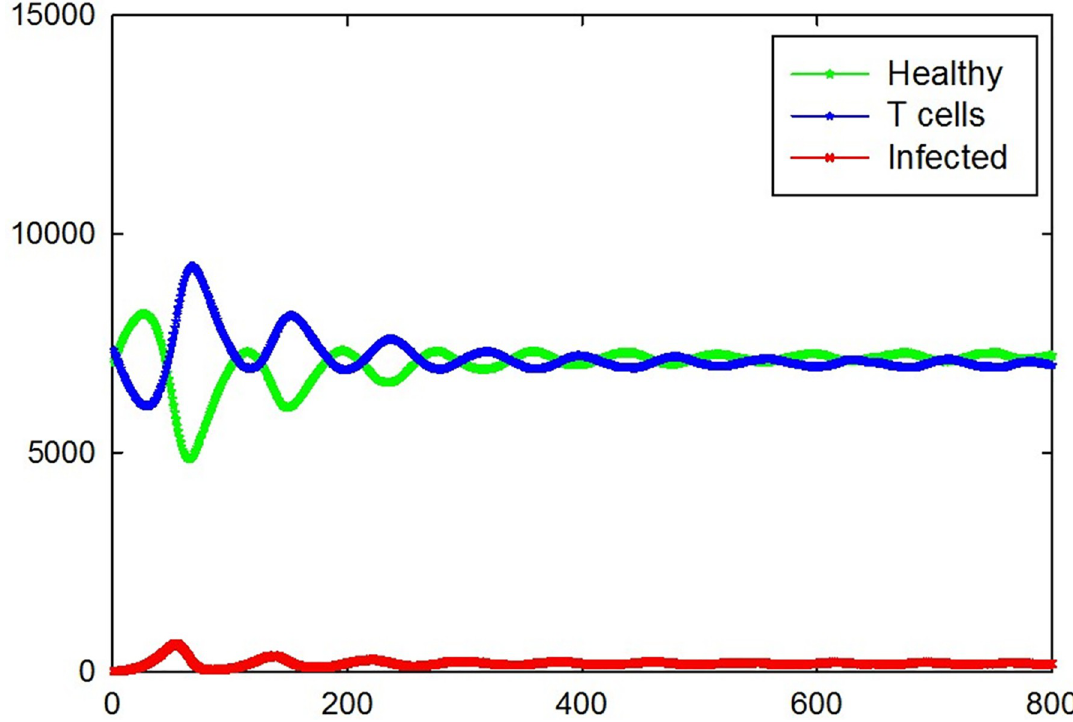
Fig 8. Total number of healthy, infected, and T cells versus time for the case of P I = 1, P T = 0.4, P H = 0.4, and P D =